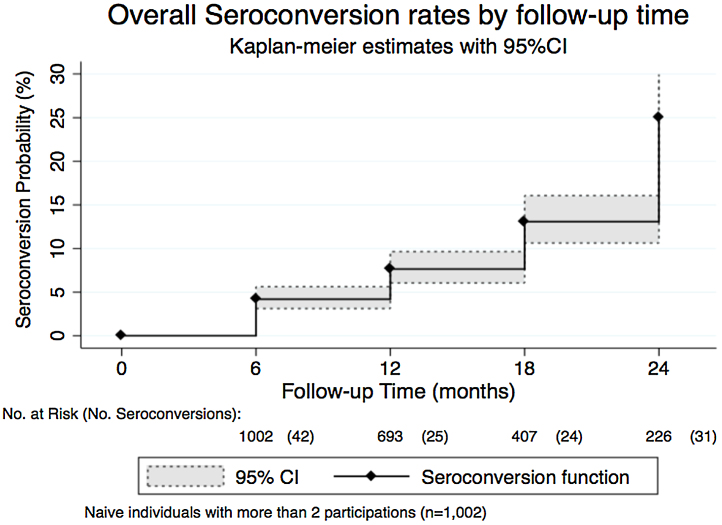
Seroconversion rate per visit. Overall seroconversion rate in dengue-naïve subjects at baseline by follow-up time. Includes the number at risk at the beginning of the time period and the number of events (new infections) in parenthesis. The curve shows an increasing probability of seroconversion over time.